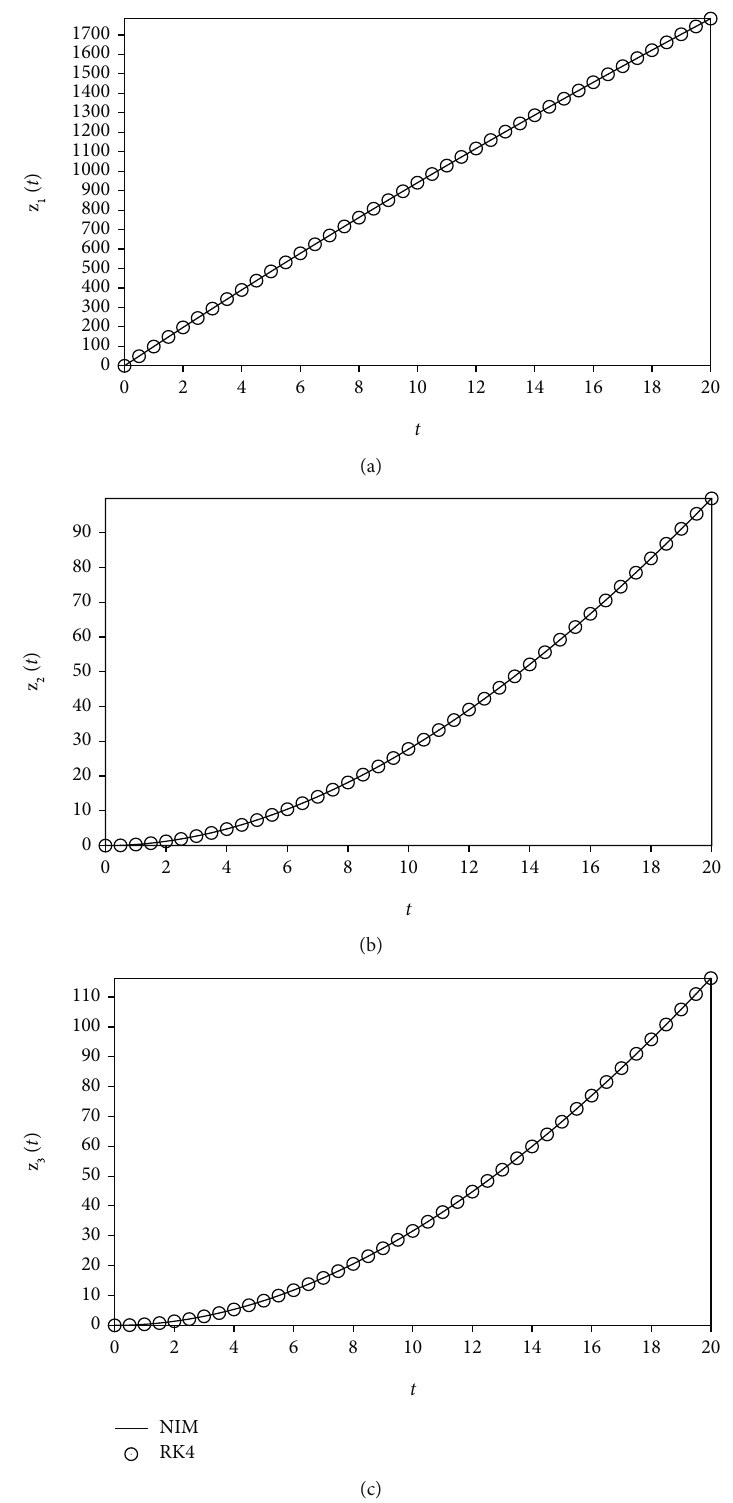
t Þ , (b) z t Þ , and (c) z t Þ in the impulse input 1 ð 2 ð 3 ð